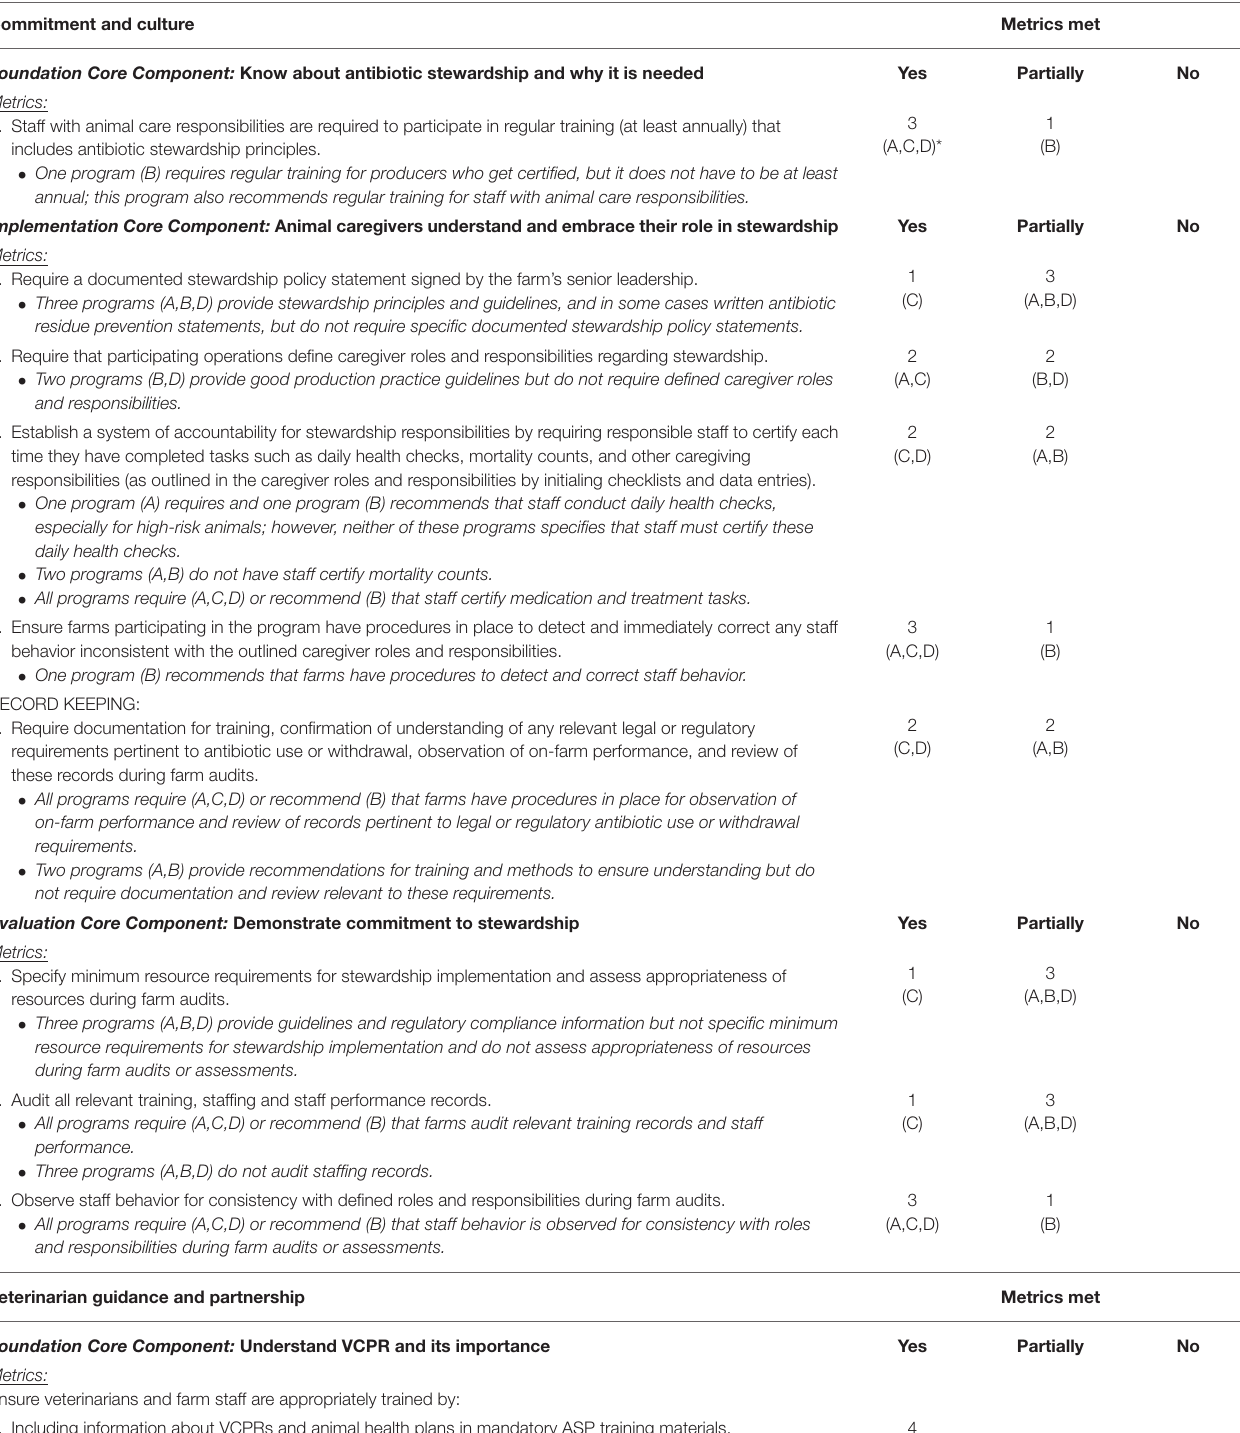
TABLE 3 | Summary of individual metrics of antibiotic stewardship met by the programs evaluated. Commitment and culture Metrics